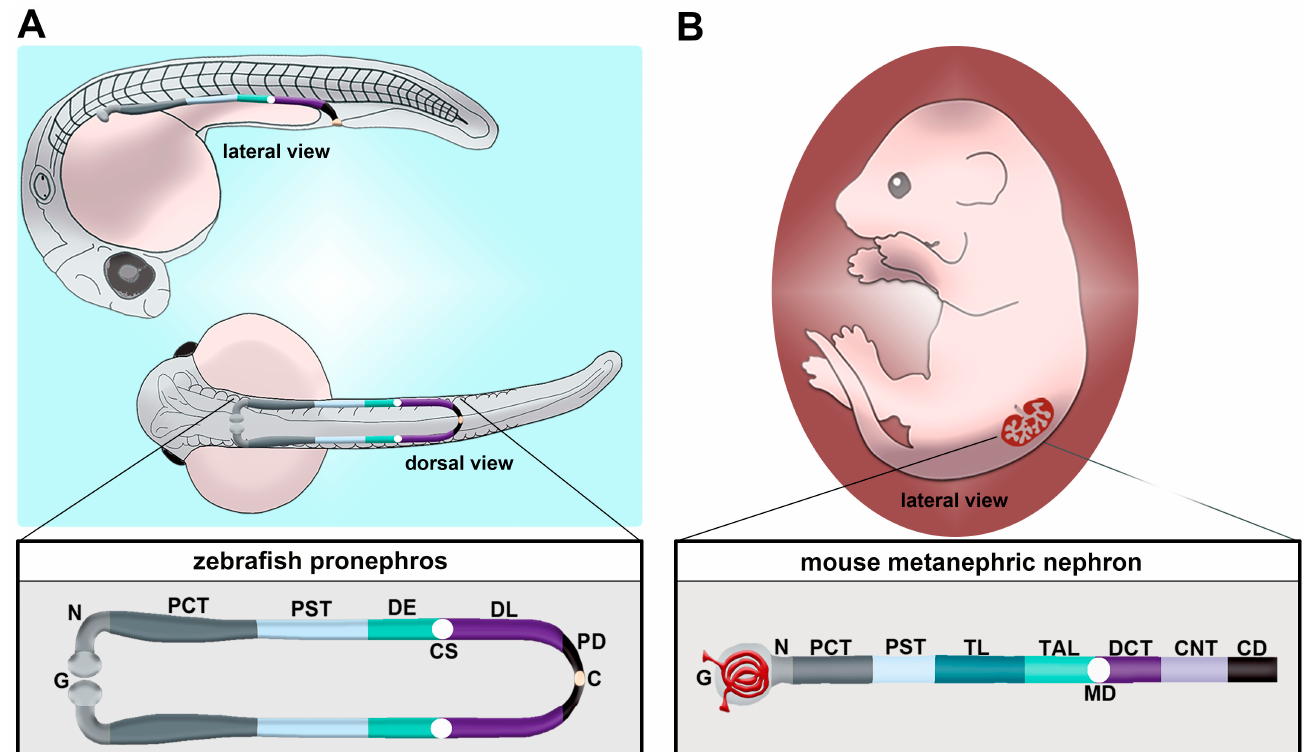
Figure 1. Comparison of nephron segment composition between the zebrafish and the mouse. ( A ) The zebrafish embryo forms a pronephros that consists of two nephrons located on either side of the midline, which form by the 24 hours post fertilization (hpf) stage and quickly undergo morphogenesis events that enable them to begin blood filtration by approximately 48 hpf. ( B ) Nephron composition in the mouse metanephros; note that the nephron is drawn here in a linear configuration, but it would display a folded / convoluted anatomical configuration within the native kidney. There is a striking conservation of proximal and distal segments, but the thin limb is one notable distinction between these nephron forms. Abbreviations are as follows: P = podocytes; N = neck; PCT = proximal convoluted tubule; PST = proximal straight tubule; DE = distal early; CS = Corpuscle of Stannius; DL = distal late; CD = collecting duct; TL = thin limb; TAL = thick ascending limb; MD = macula densa; DCT = distal convoluted tubule; CNT = connecting tubule.